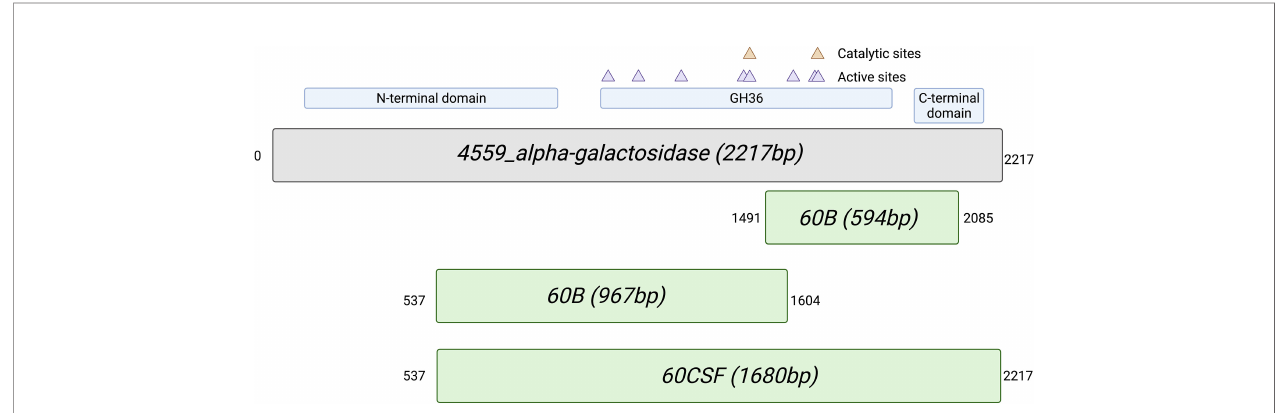
FIGURE 9 | Alignment of the alternative alpha-galactosidase gene with putative gene fragments. Gene fragments of 60B and 60CSF that correspond to an alternative alpha-galactosidase (protein ID: WP_000158269.1; locus tag: FJH52_RS10440; gene ID: GI:446080414) found in S. pneumoniae strain 4559. The blood isolate, 60B, contained fragments that were 594bp and 967bp in length, whilst the CSF isolate, 60CSF, contained a single fragment of 1680bp. Numbers outside of gene fragments correspond to nucleotide position within strain 4559 alpha-galactosidase. A conserved domain search was performed on using NCBI conserved domain search (Lu et al., 2020). A glycosyl hydrolase family 36 (GH36) motif was found in strain 4559 alternative alpha-galactosidase. Two aspartic acid residues have been identi fi ed as the catalytic nucleophile and the acid/base, respectively, as indicated by the orange triangles. Active sites within the GH36 motif are indicated by purple triangles. A glycosyl hydrolase family 36 N-terminal domain, with a beta-supersandwich fold, and a glycosyl hydrolase family 36 C-terminal domain, with a beta-sandwich structure with a Greek key motif, were also located within the strain 4559 alternative alpha-galactosidase.